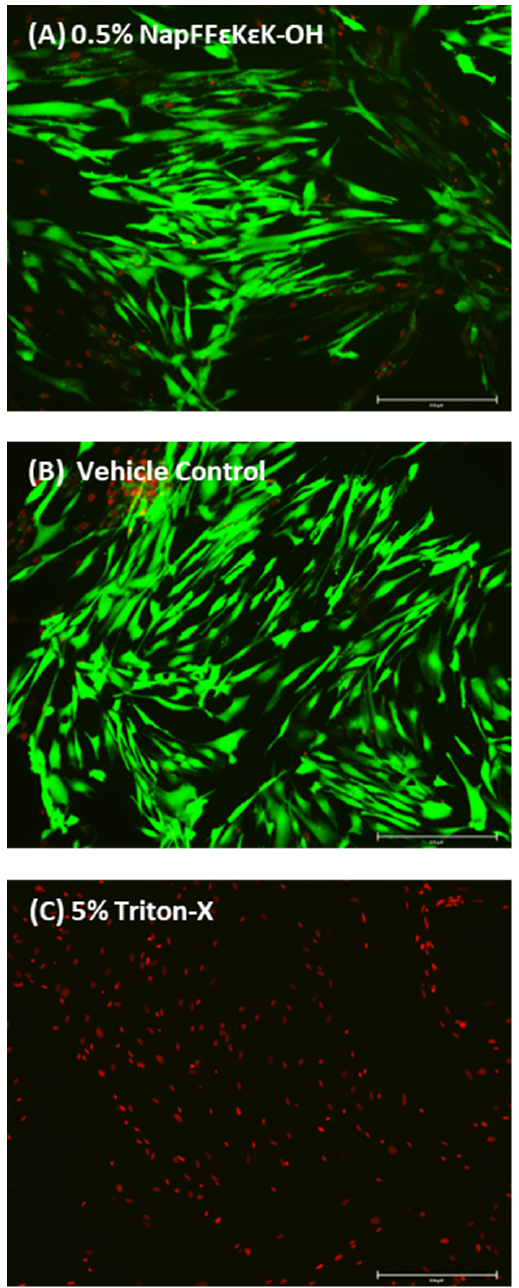
Figure 3. Live/dead viability/cytotoxicity assay showing representative images of ( A ) DPSCs treated with Day 14 conditioned media obtained from 0.5% w / v NapFF ε K ε K ‐ OH hydrogels, ( B ) vehicle control ( α ‐ MEM incubated for 14 days at 37 °C prior to cell treatment) and ( C ) DPSCs treated with 5% v / v Triton-X. Images A and B show mainly live cells, stained green with calcein AM, with very few cells stained red, whereas in C dead cells are stained red with EthD-1. Images were captured using an Evos FL Auto Imaging System. Scale bars: 250 μ m.